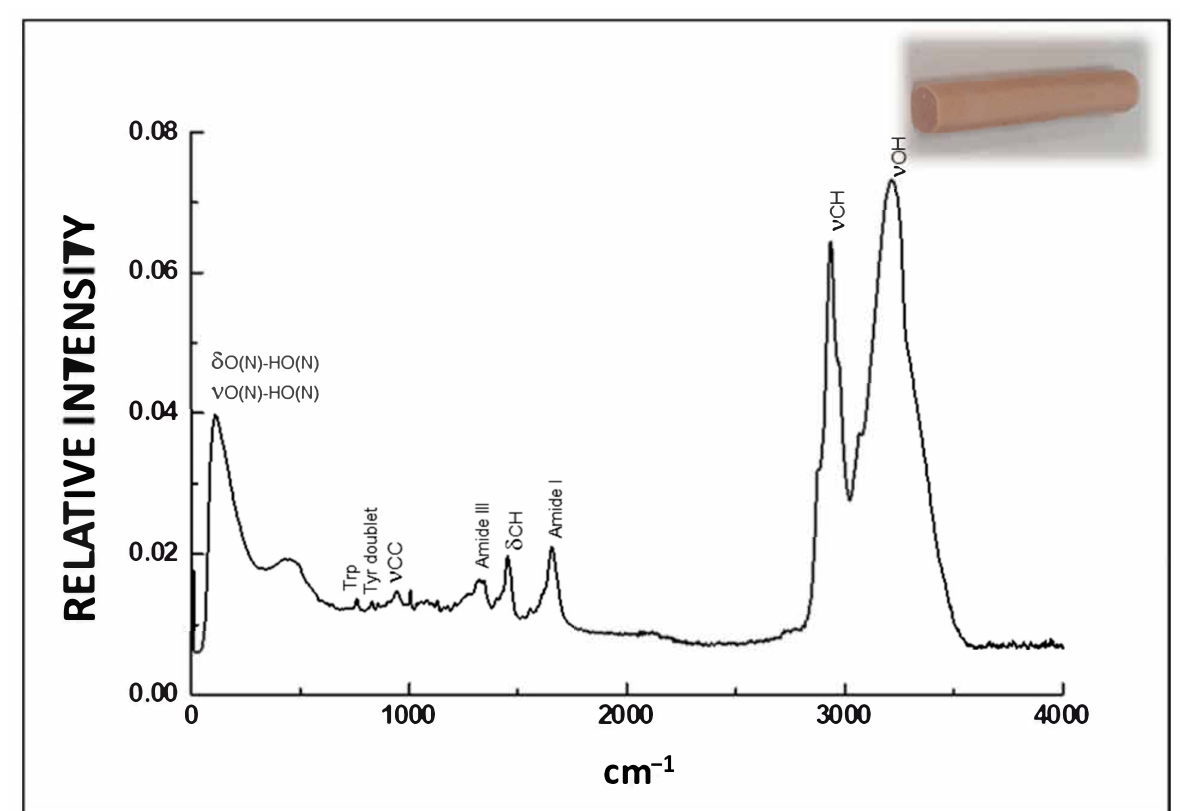
Figure 4. Typical Raman spectrum of a cooked sausage (type frankfurter) in the 0–4000 cm − 1 . There are also several Raman bands allocated to lipids near 1750, 1660, 1470, 1443, 1306, and 1269 cm − 1 allocated to the C=O stretching modes, C=C stretching modes, CH